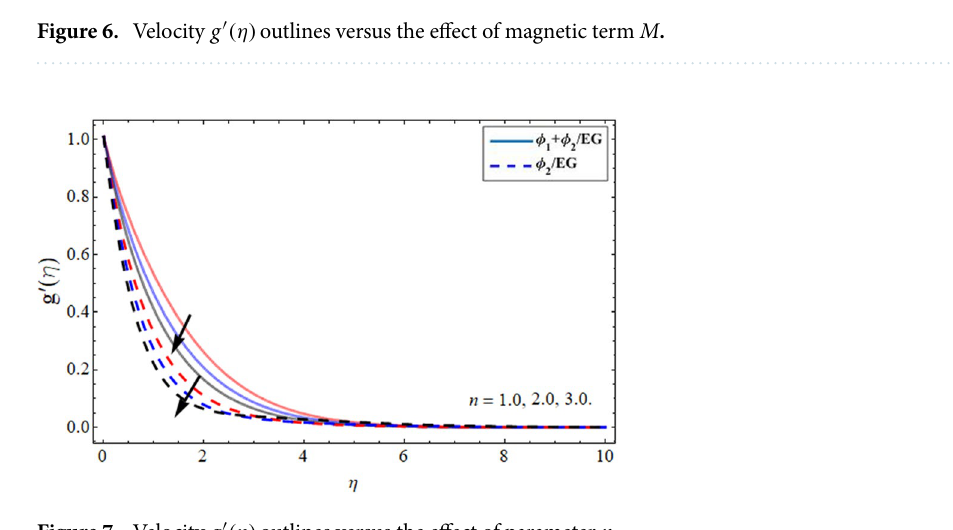
Figure 7. Velocity g ′ (η) outlines versus the effect of parameter n